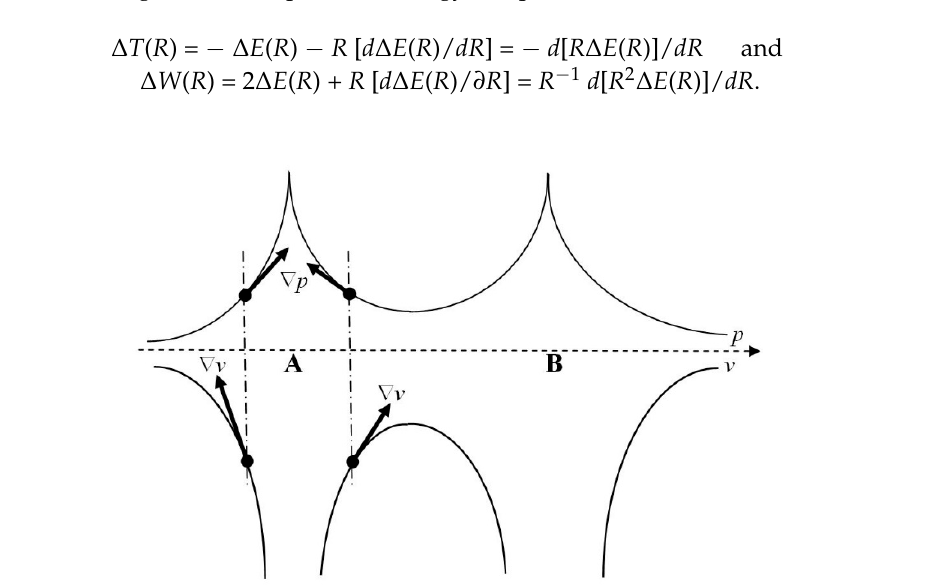
Figure 2. Variations of the electronic energy Δ E ( R ) (solid line) with the internuclear distance R in a diatomic molecule and of its kinetic energy component Δ T ( R ) (broken line) determined by the virial theorem partition.4. Reactivity Implications of Molecular Virial Theorem. Consider next the (intrinsic) reaction coordinate R c , or the associated progress variable P = | R c | , of the arc length along this trajectory, for which the virial relations also assume the diatomic-like form. The virial theorem decomposition of the energy profile E ( P ) along R c in bimolecular reaction